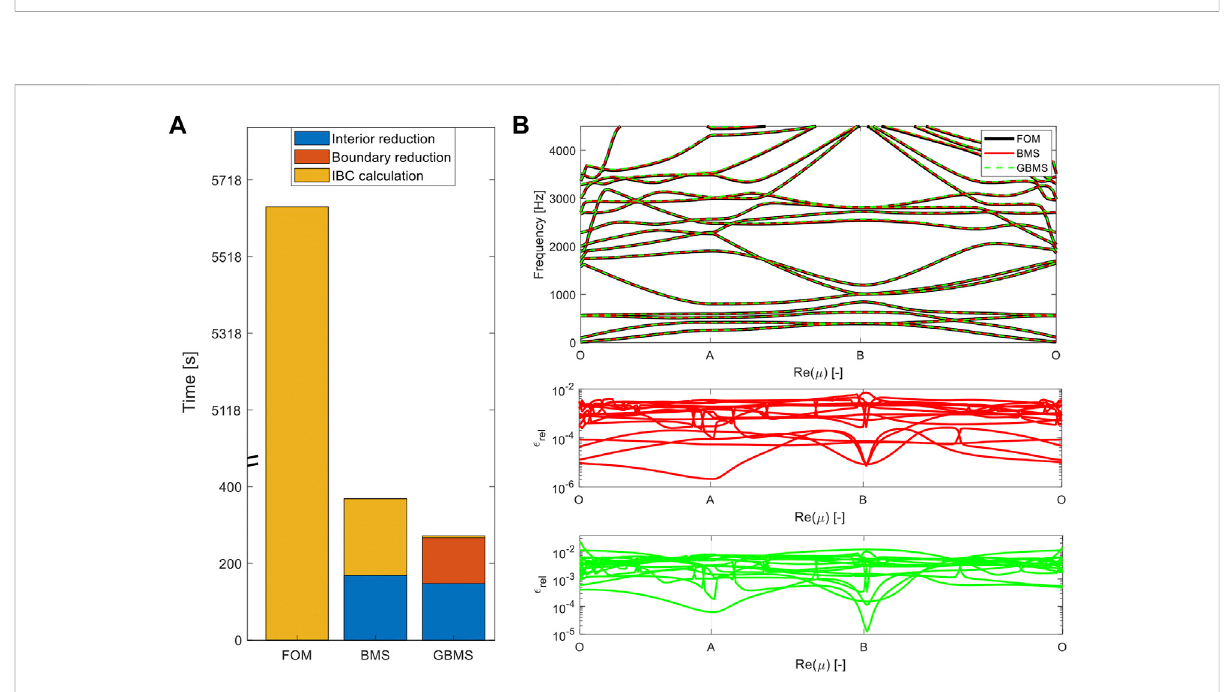
FIGURE 3 Results of the vibro-acoustic 2D periodic case. (A) Comparison of the different calculation times for the construction of the ROM and the dispersion curve calculation. (B) Dispersion curves of FOM and ROMs with corresponding relative